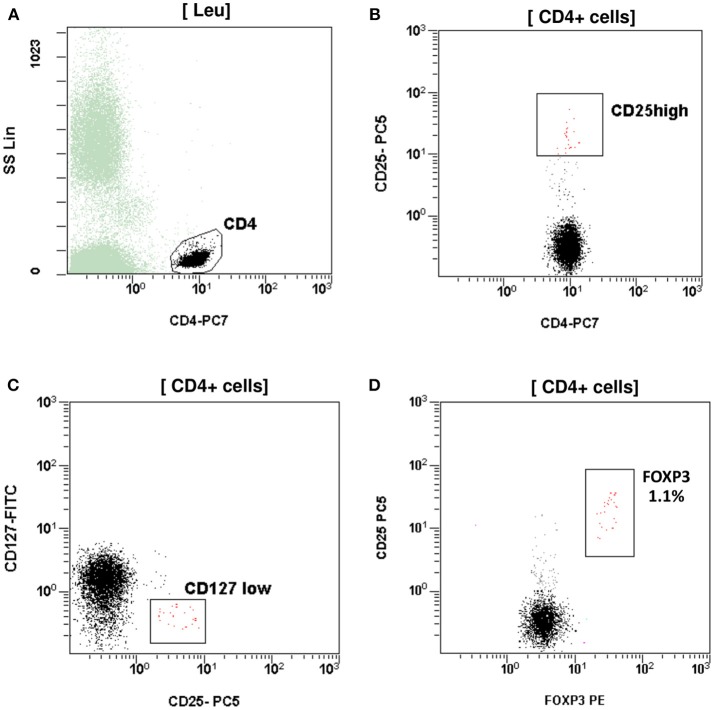
T regulatory cells (Tregs) assessed as CD4+CD25highCD127lowFOXP3+. (A) CD4+ T cells gated by CD4 and side scatter (SS). (B) Treg CD4+CD25high. (C) Treg CD4+CD25+CD127 low. (D) Treg CD4+CD25+FOXP3+. The percentage (1.1%) and absolute number (20 cells/mmL) of Treg was reduced compared to reference age values (4–8% and 63–690 cells/mmL respectively).